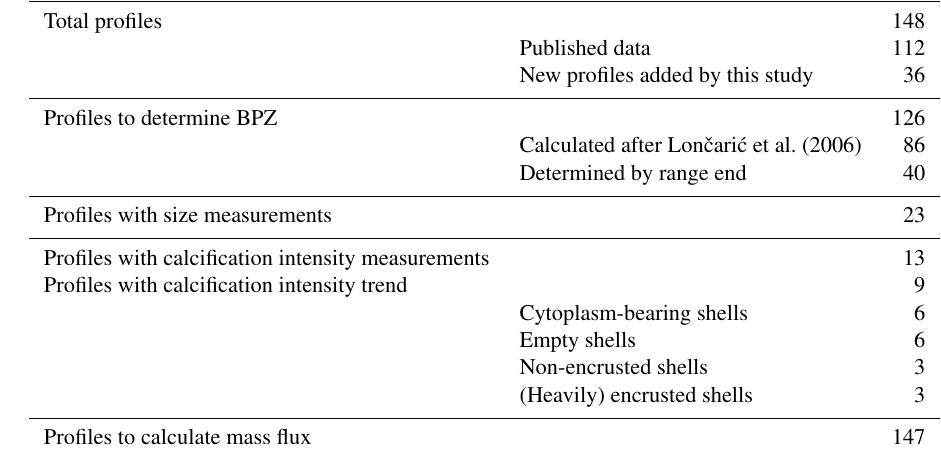
Table 2. Overview of the numbers of depth profiles used in the study, with varying numbers depending on the studied